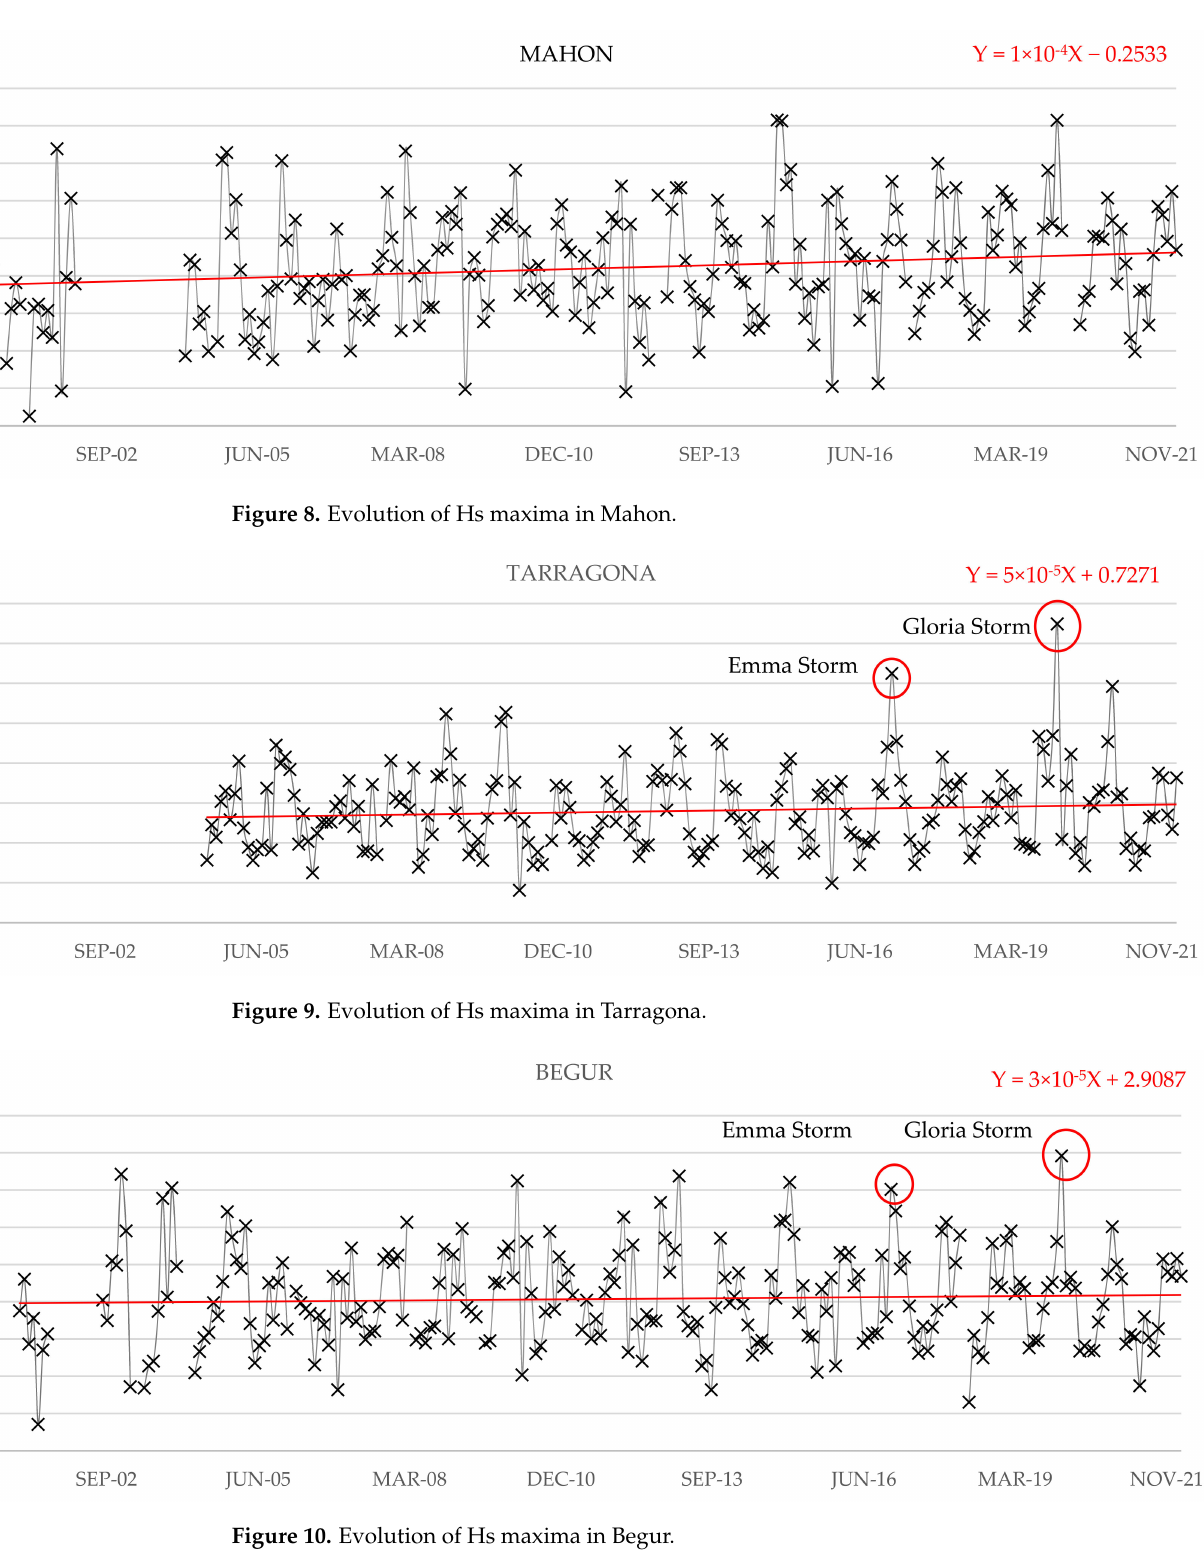
Figure 10. Evolution of Hs maxima in